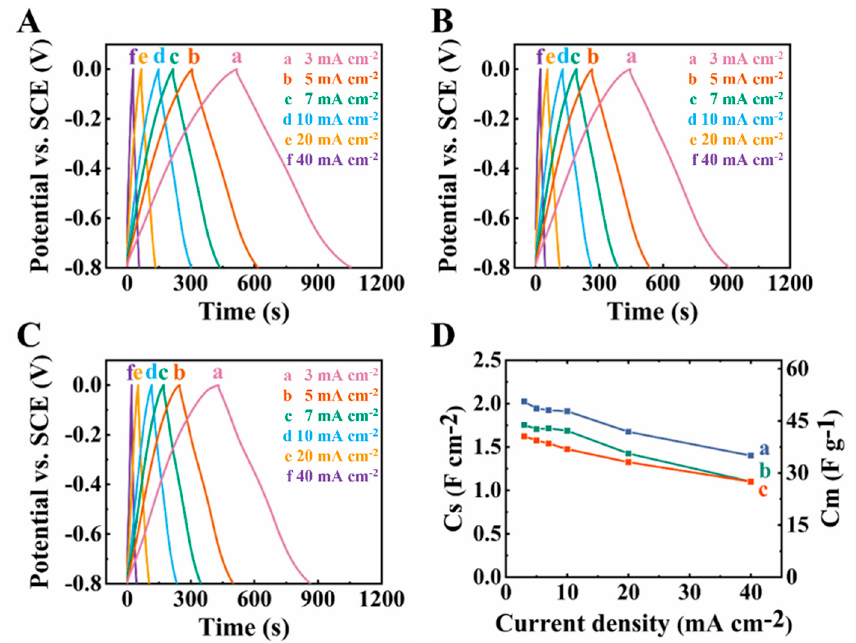
Figure 8. ( A – C ) galvanostatic charge discharge data at current densities of (a) 3, (b) 5, (c) 7, (d) 10, (e) 20 and (f) 40 mA cm − 2 for ( A ) CFO-10, ( B ) CFO-20 and ( C ) CFO-30 electrodes; ( D ) capacitance versus current density for (a) CFO-10, (b) CFO-20 and (c) CFO-30 electrodes.